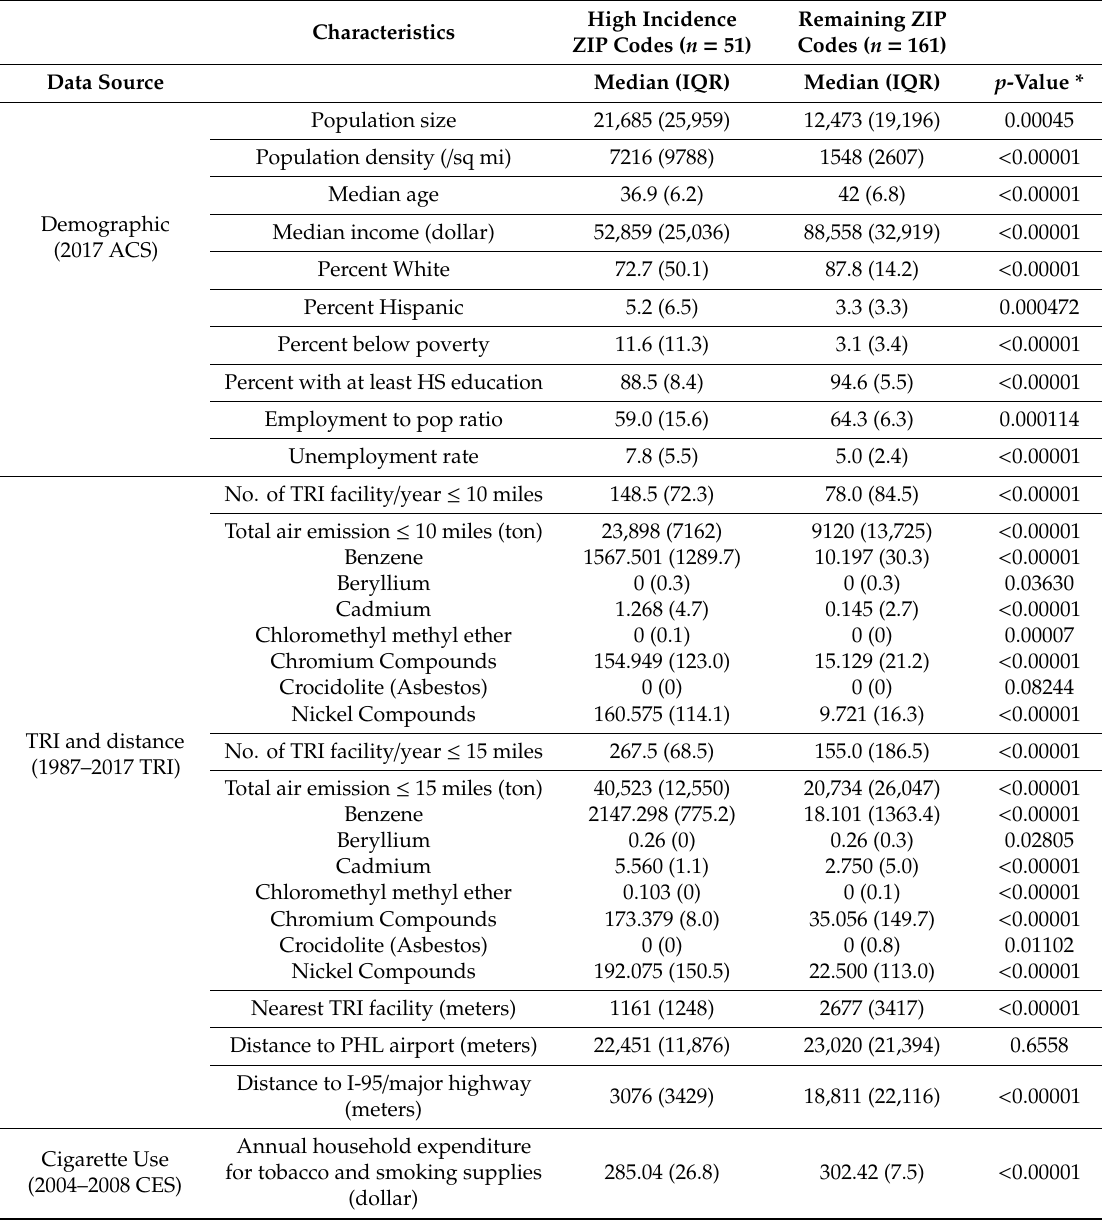
Table 1. Comparisons of demographic, Toxic Release Inventory (TRI), and distance characteristics: high incidence ZIP codes versus the remaining ZIP codes. Data are presented as median